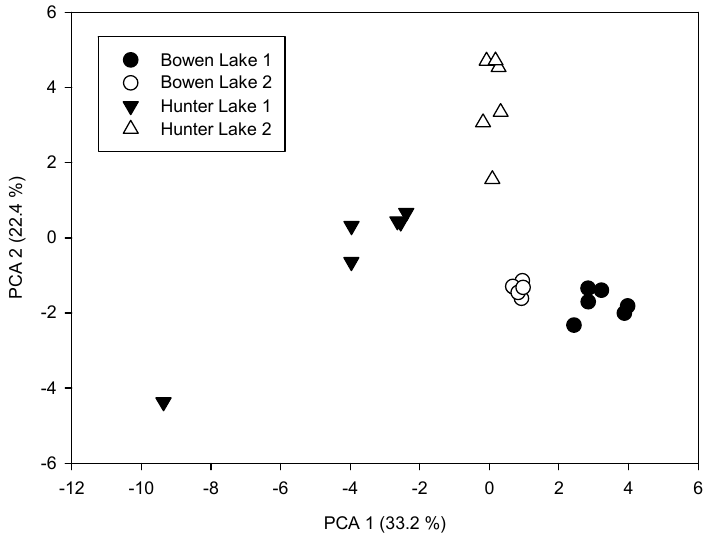
Figure 6. Principal component analysis (PCA) ordination of water chemistry variables from pit lakes in the Bowen Basin, Queensland and the Hunter Basin, New South Wales, Australia. Data shows an overlay of “lake” as indicated in figure legend.